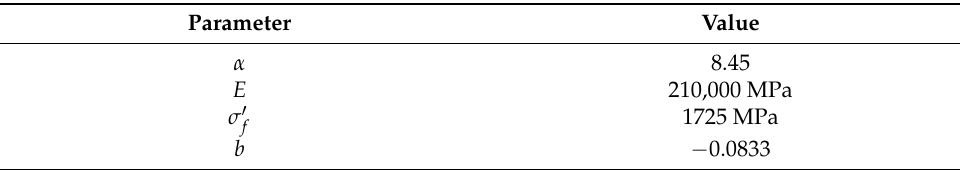
Table 3. The model parameters of the KBM model.